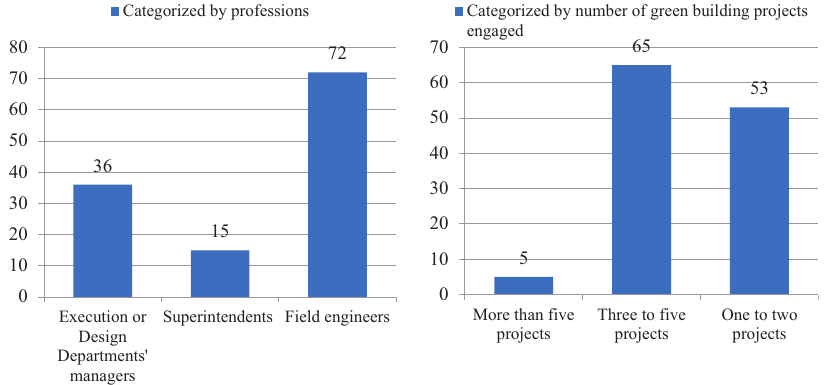
Figure 2. Respondent